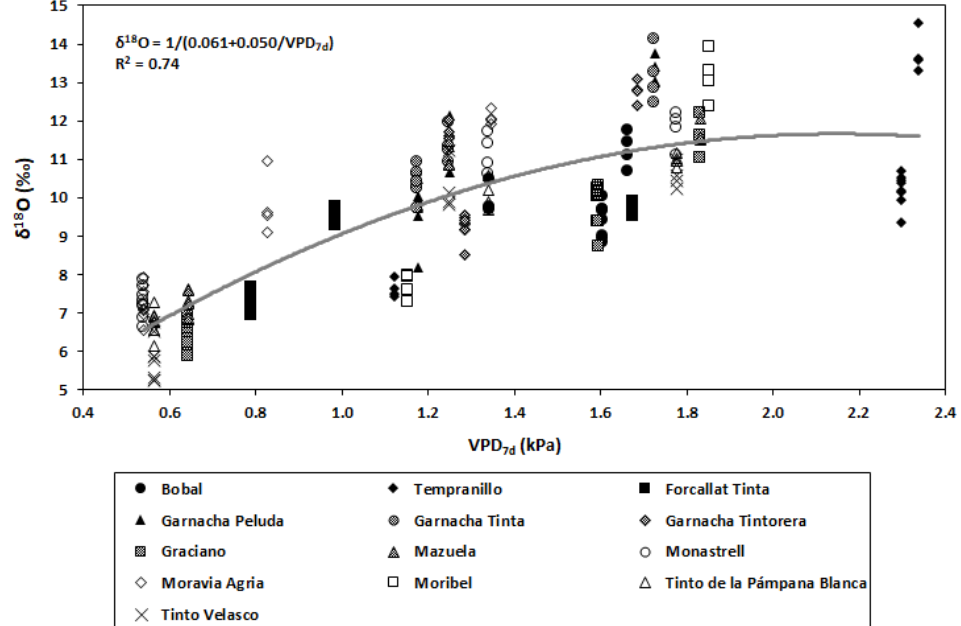
Figure 4. Relationship between grape must δ 18 O and VPD 7d under severe water stress conditions for 13 red cultivars from 2018 to 2020. The points on the graph represent the δ 18 O and daily mean VPD 7d values prior to the date of harvest of the individual vines. The curve represents the double inverse fit between the two variables.